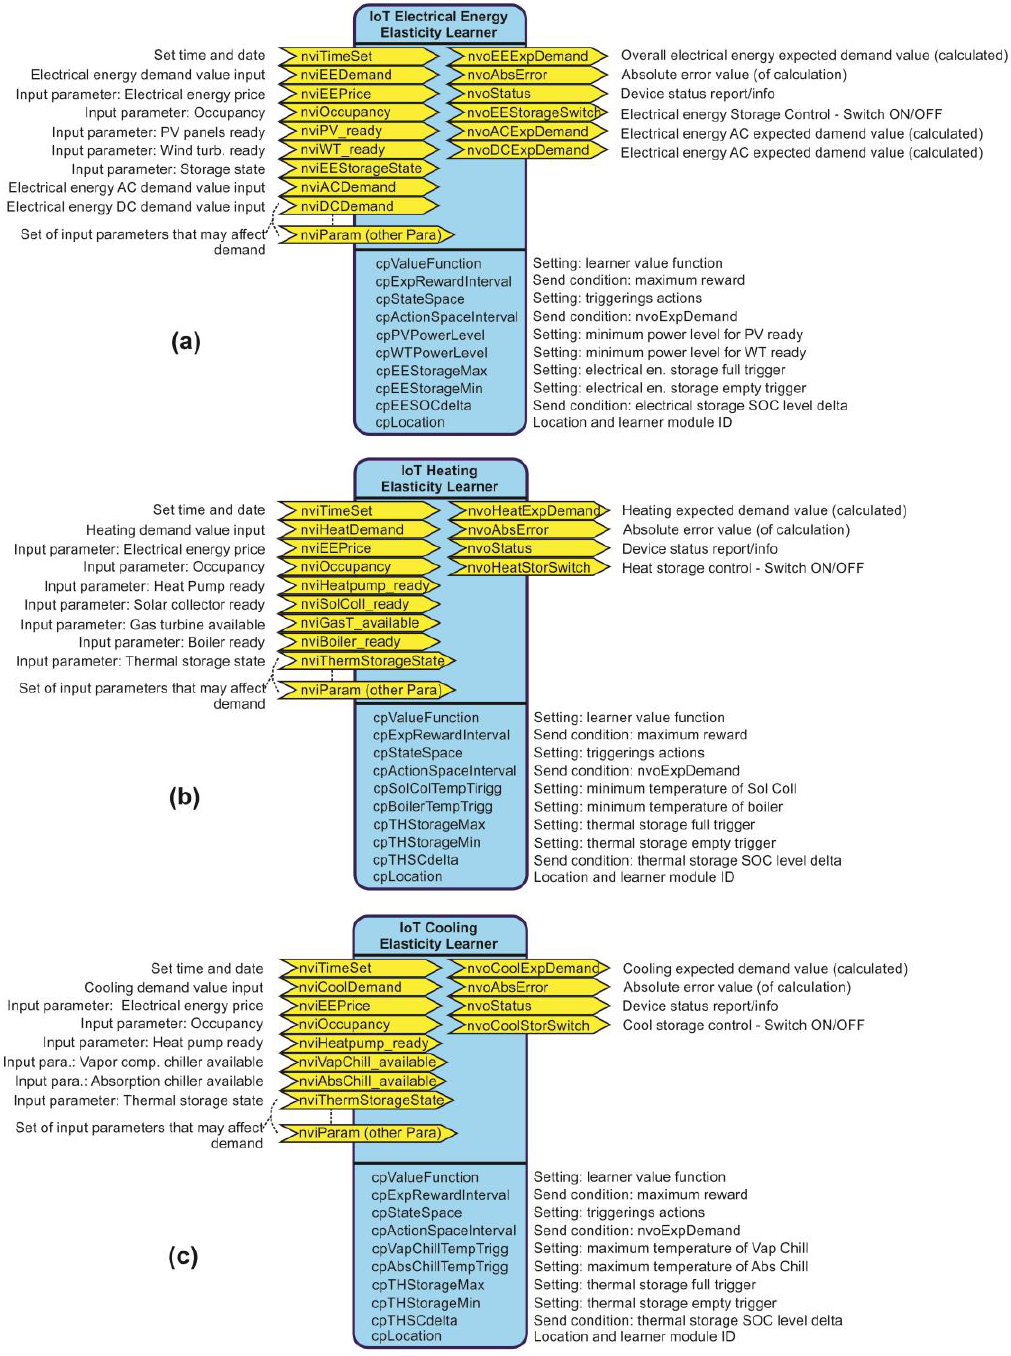
Figure 5. Developed IoT Demand Elasticity Learner functional blocks: ( a ) for electrical energy DSM; ( b ) for heating DSM; ( c ) for cooling DSM.